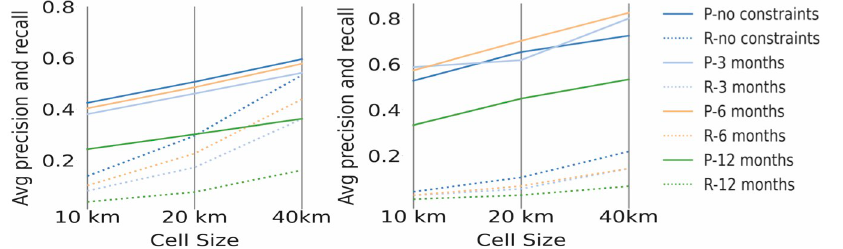
Fig 7. Average precision and recall comparison per cell size and temporal restriction for invasive species: One by one analysis on the left, three by three analysis on the right, where ‘P’ refers to precision and ‘R’ refers to recall. ’no constraints’ refers to analyses performed with no temporal